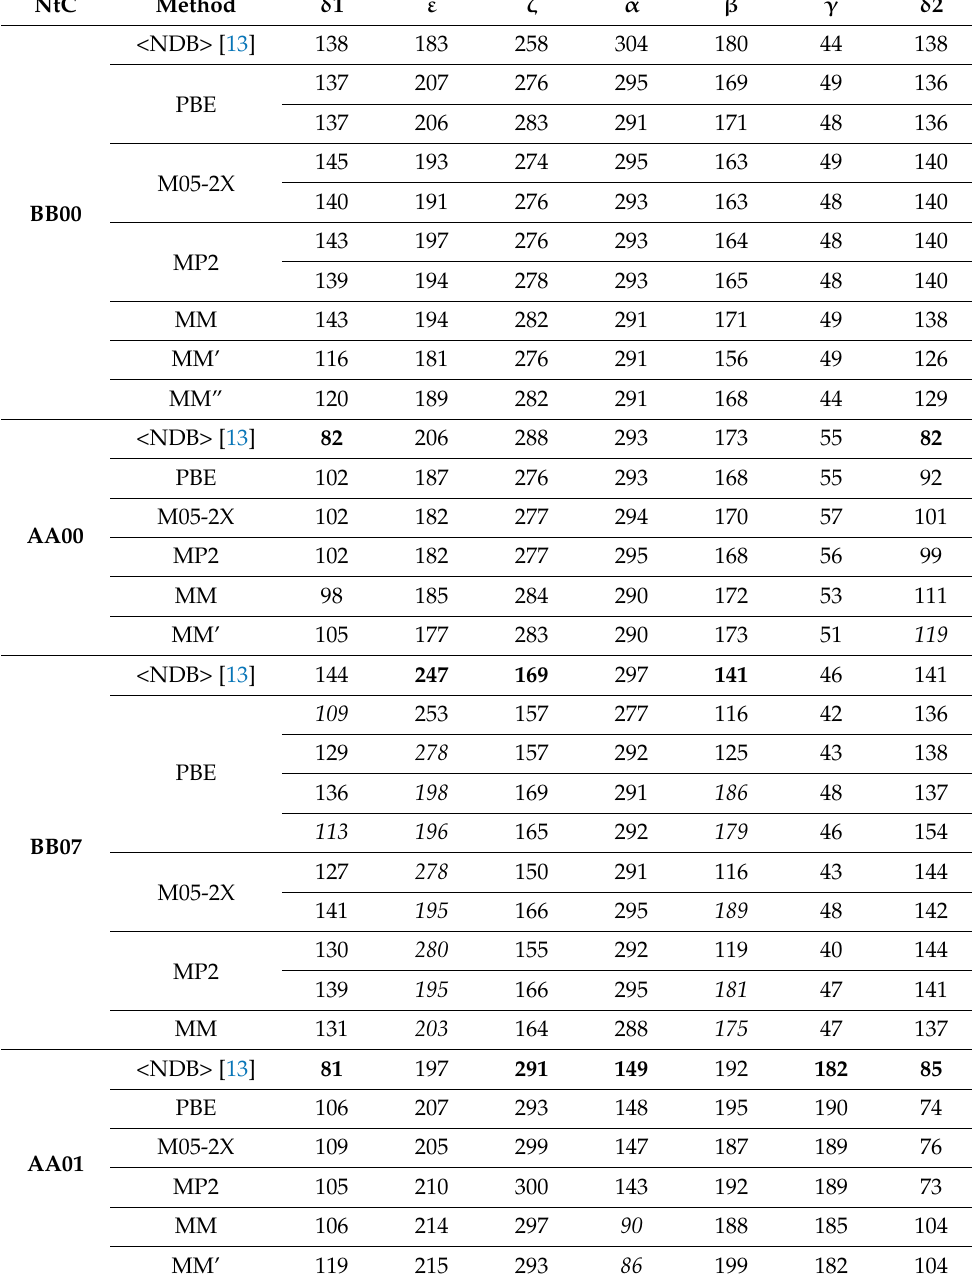
Table 2. Averaged torsion angles of the sugar-phosphate backbone for BI (BB00), BII (BB07), AI (AA00), and AII (AA01) conformations of experimental structures [13] and theoretical structures of separate SPB fragments optimized by various